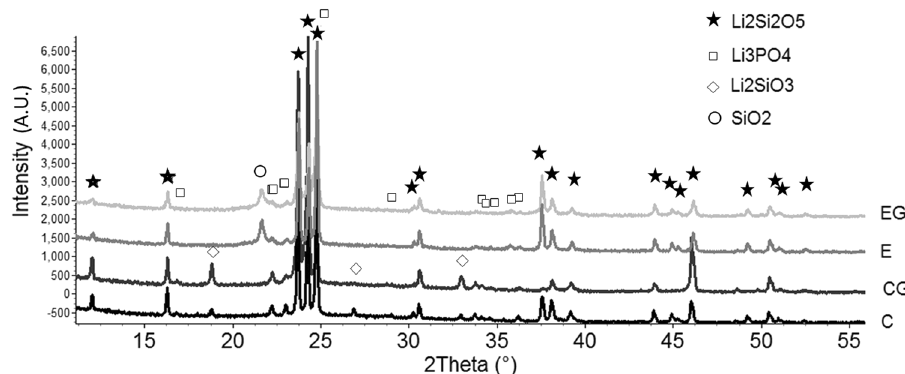
Table 2 Quantitative phase analysis for groups C, CG, E and EG Group